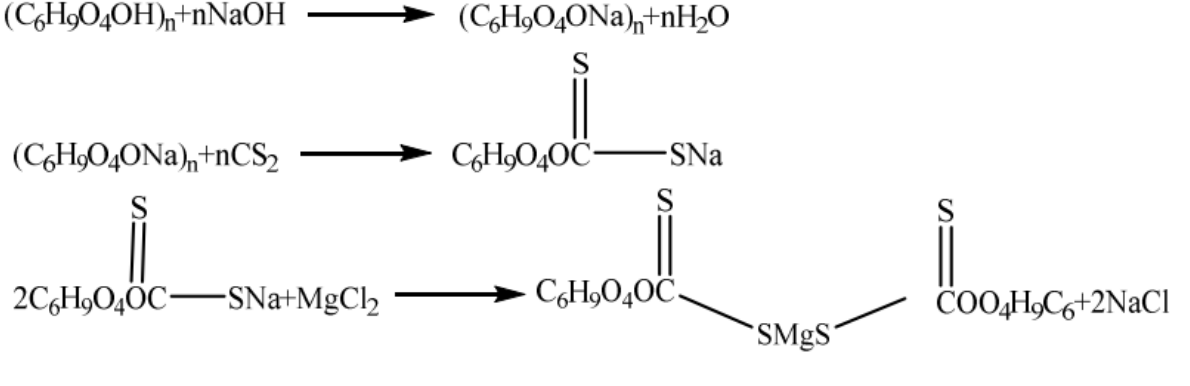
Figure 1. The preparation of MDG.